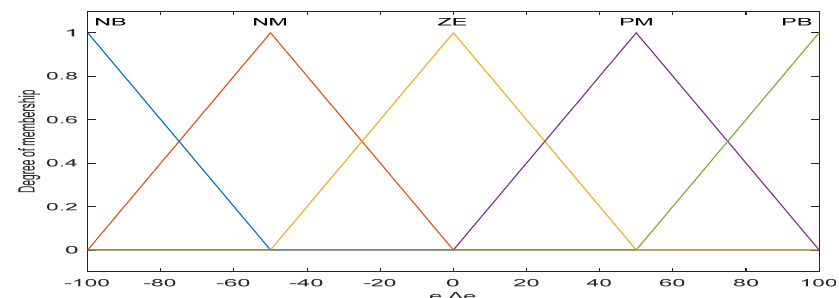
Figure 10. MFs for e and Δ e.